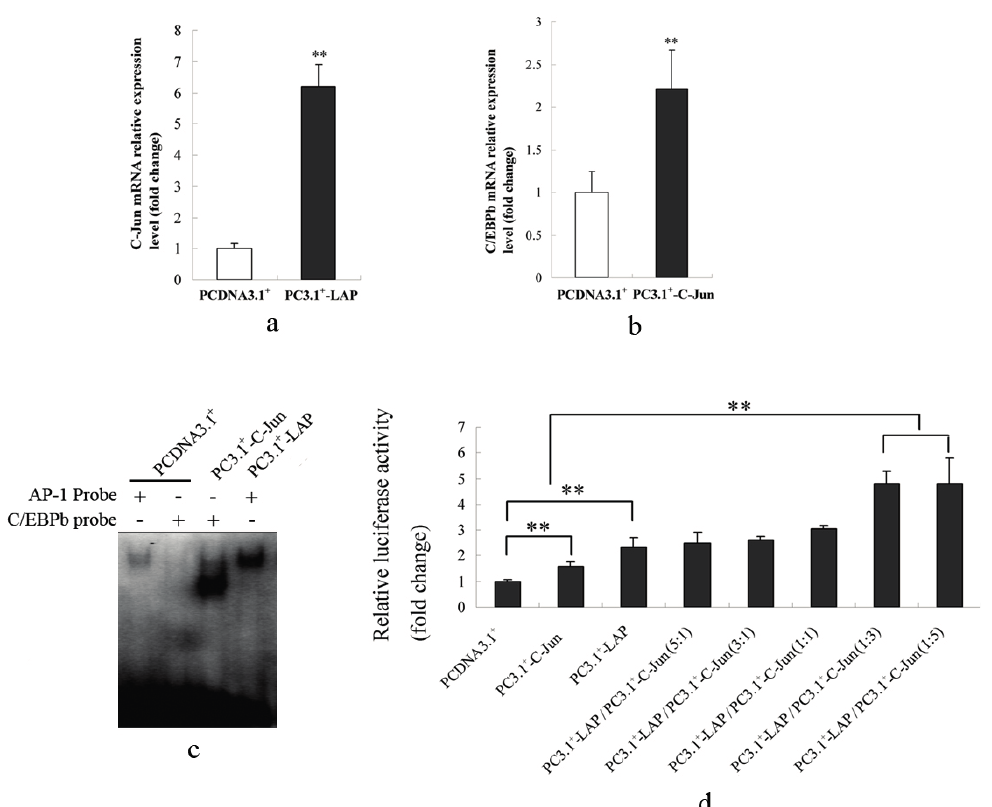
Figure 5. Synergetic effects of C/EBP β and AP-1 in the transcriptional regulation of the porcine S100A12 gene in PK-15 cells. ( a ) C/EBP β transcription levels were